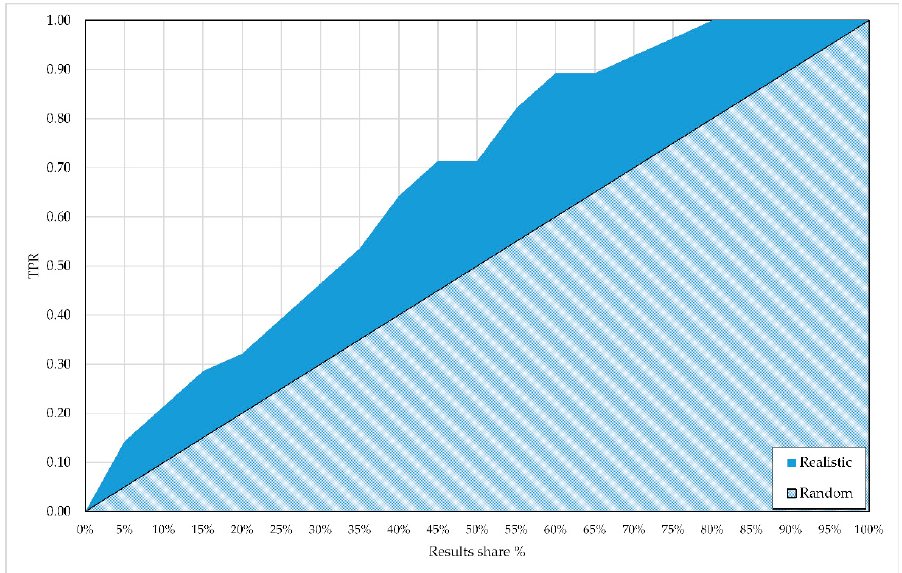
Figure 4. Areas under lift chart 𝐴 (cid:3039)(cid:3036)(cid:3033)(cid:3047) for a realistic (blue area) and random classifier (shaded blue area). The 𝐴 (cid:3039)(cid:3036)(cid:3033)(cid:3047) of the realistic classifier includes that of the random classifier. As in the previous figure, true positive rate is represented on the y -axis and share of total results is on the x